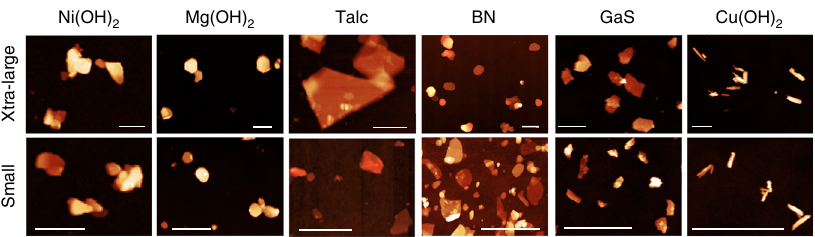
Fig. 2 AFM characterisation of liquid-exfoliated nanosheets. Representative AFM images of size-selected 2D materials showing (top row) the extra-large (XL) fraction and (bottom row) the small (S) fraction. Sample images are shown in the Supplementary Figure 7 with z -axis scale bars. Spatial scale bars are as follows: Ni(OH) 2 , 200 nm; Talc, 500 nm; Mg(OH) 2 , BN, GaS, Cu(OH) 2 , 1 μ m